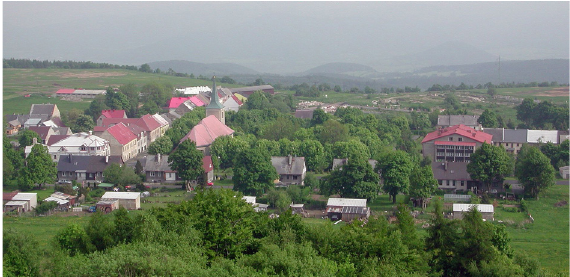
Fig. 3. Měděnec – originally a settlement of copper miners. The village lost 95% of its population since 1930. Photo by A. Vaishar.